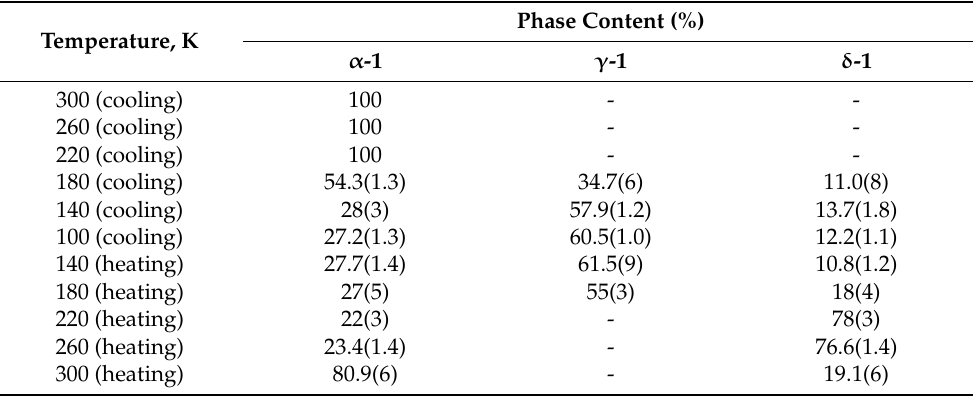
Figure 2. Diffractograms of 1 at 300 K (as synthesized; at the top), at 100 K (second from top), at 260 K after cooling at 100 K (second from bottom), and at 300 K after cooling to 100 K (at the bottom) ( λ = 0.74 Å ). Table 2. The content of phases in sample 1 determined by the Rietveld method at different tempera- tures during cooling (300–100 K) and heating (100–300